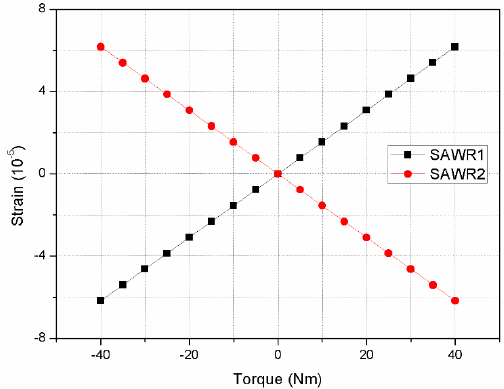
. In the full range −5 − 6.17 · 10